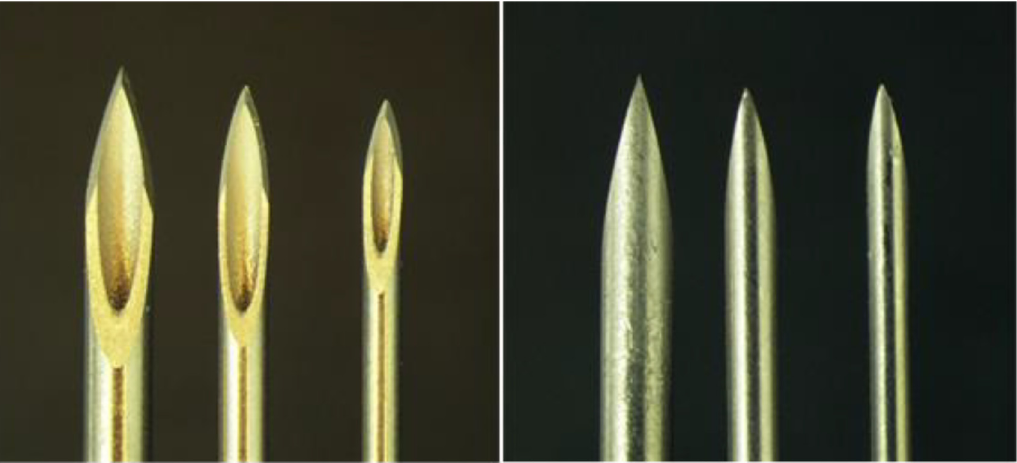
Figure 5: Examination of (left to right) 18G, 20G, and 22G conventional hypodermic needles (images viewed under 10 × eyepiece lens, 1 × objective lens, and zoomed 8 × for a total magni fi cation of 80 × ).